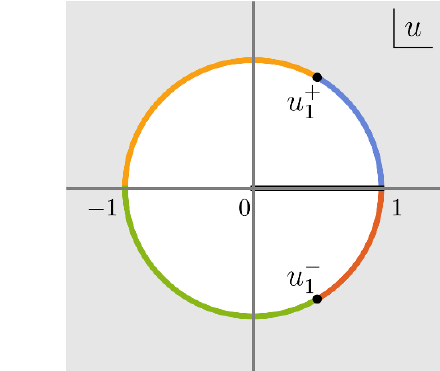
are mapped into the points u (cid:6) 1 [0 ; 1); the rays connecting the branch points t (cid:6) 2